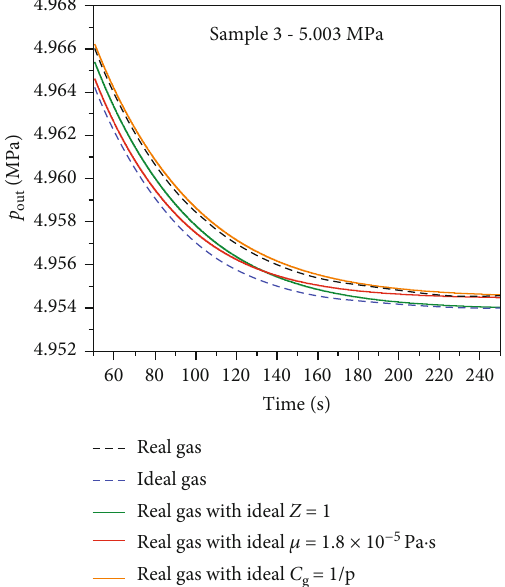
Figure 8: The simulation of real and ideal gases and the real gas simulations with ideal parameters, i.e., Z , μ , and C at 5.003MPa and 303.15 K, with Sample 3. The time interval is 50 ~ 250